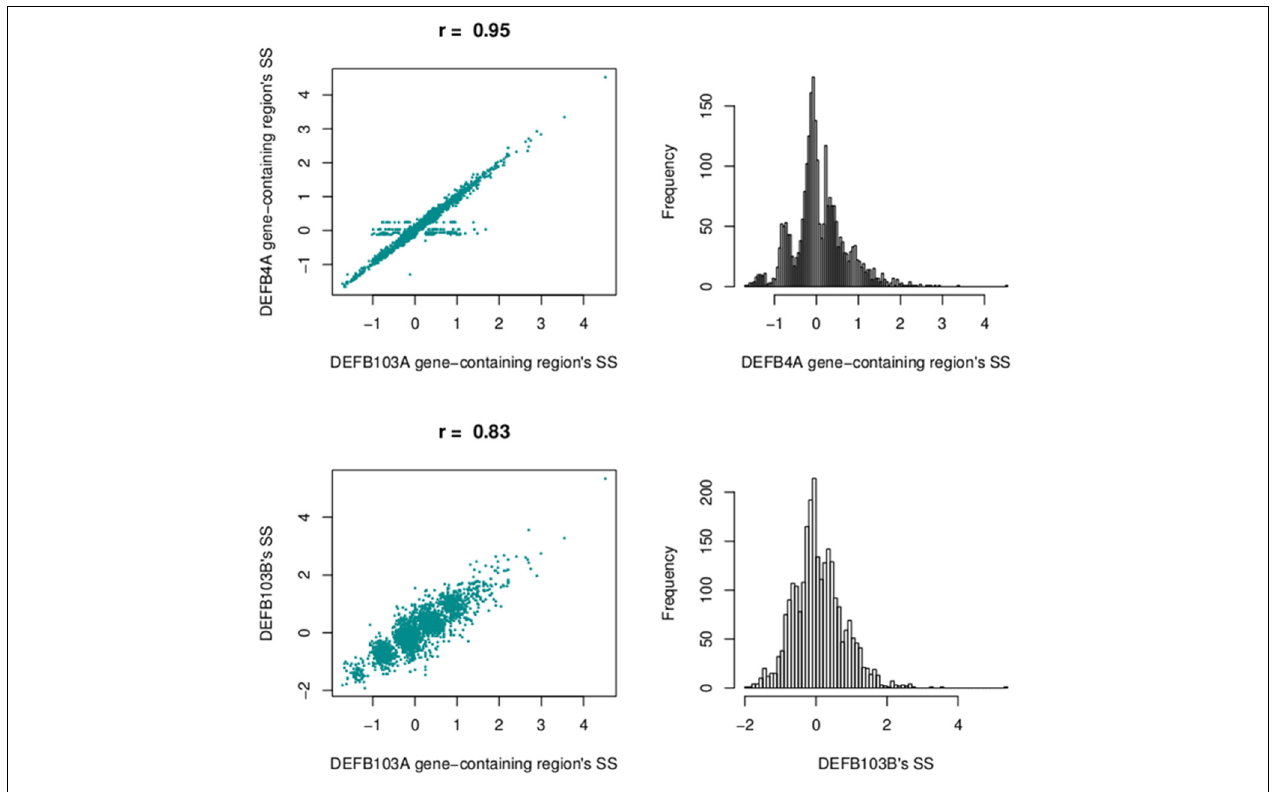
FIGURE 11 | Correlation between segmentation scores of the DEFB103A gene-containing region and the enlarged region encompassing DEFB4A (top left) and the DEFB103B gene